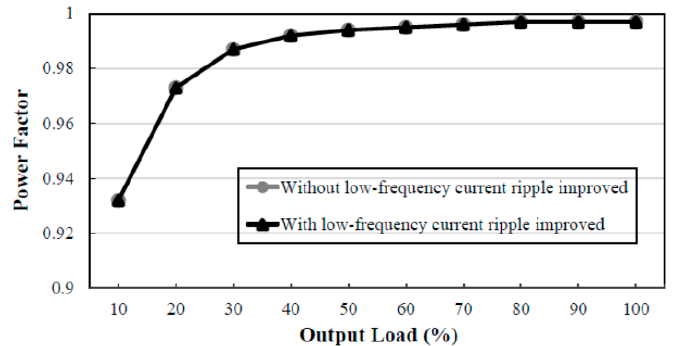
Figure 13. Curve of power factor versus output load under 110 V input voltage.